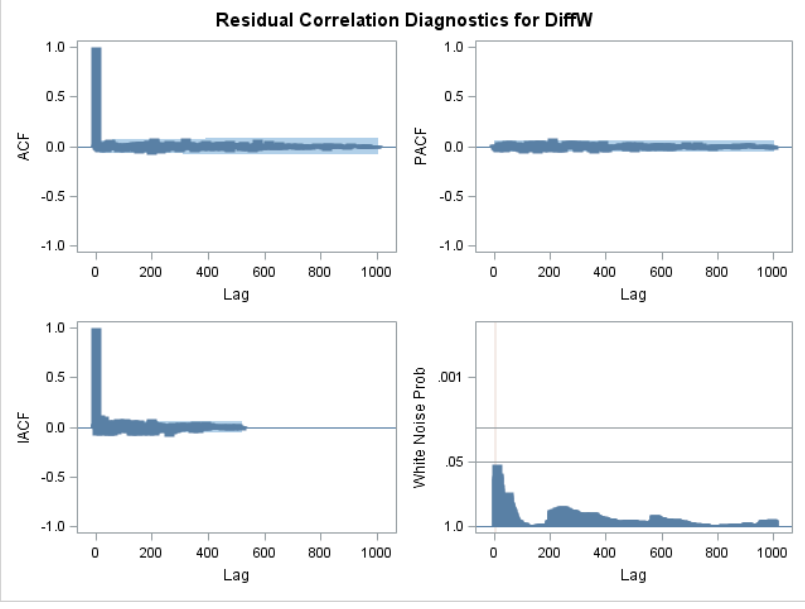
Figure A.2. Analysis of Residual for the Weekly ARMAX Model.